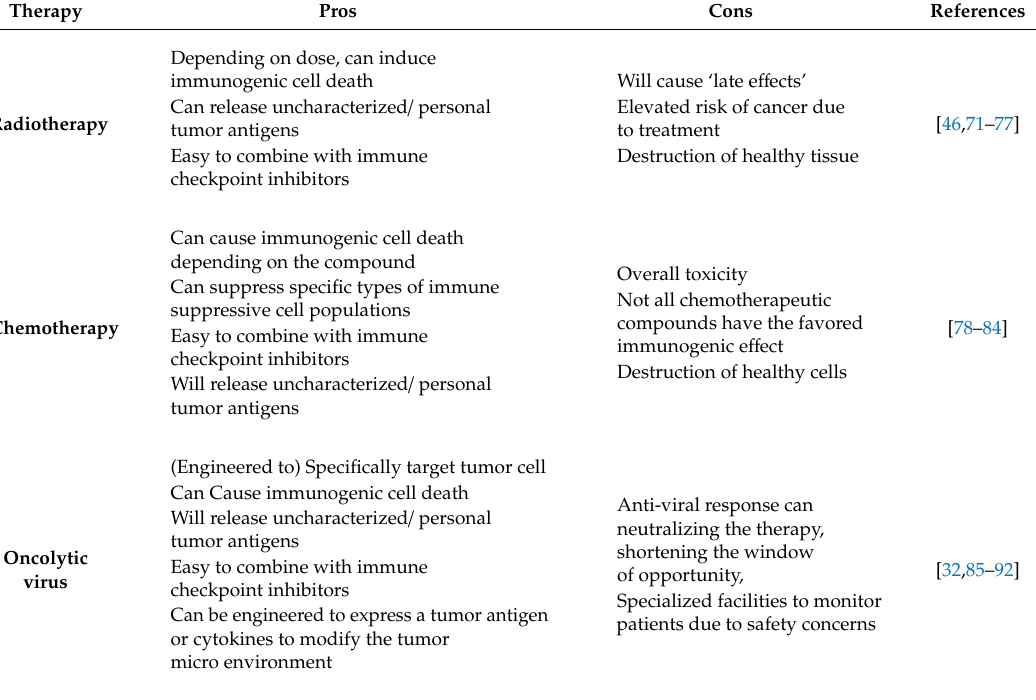
Table 2. Overview of in situ cancer vaccines with pros and